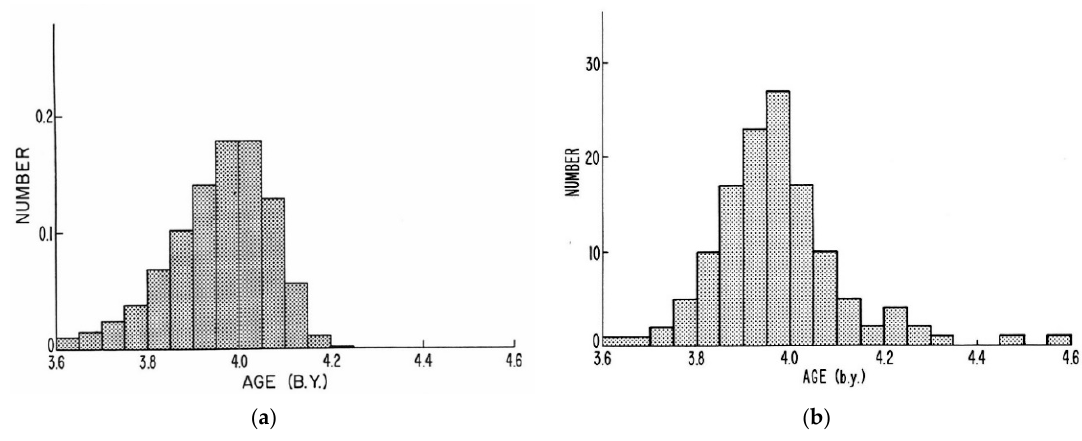
Figure 3. Wetherill’s (1975, [7]) diagrams comparing the calculated “Hartung effect” ( a ) and lunar upland rock ages ( b ). The left diagram models the competition between destruction of samples by early intense cratering and survival of samples as the cratering rate smoothly declined. The right diagram shows observed Rb–Sr and Ar–Ar age distribution from lunar highland rock samples. (Note that time proceeds from right to left, contrary to most of our diagrams).